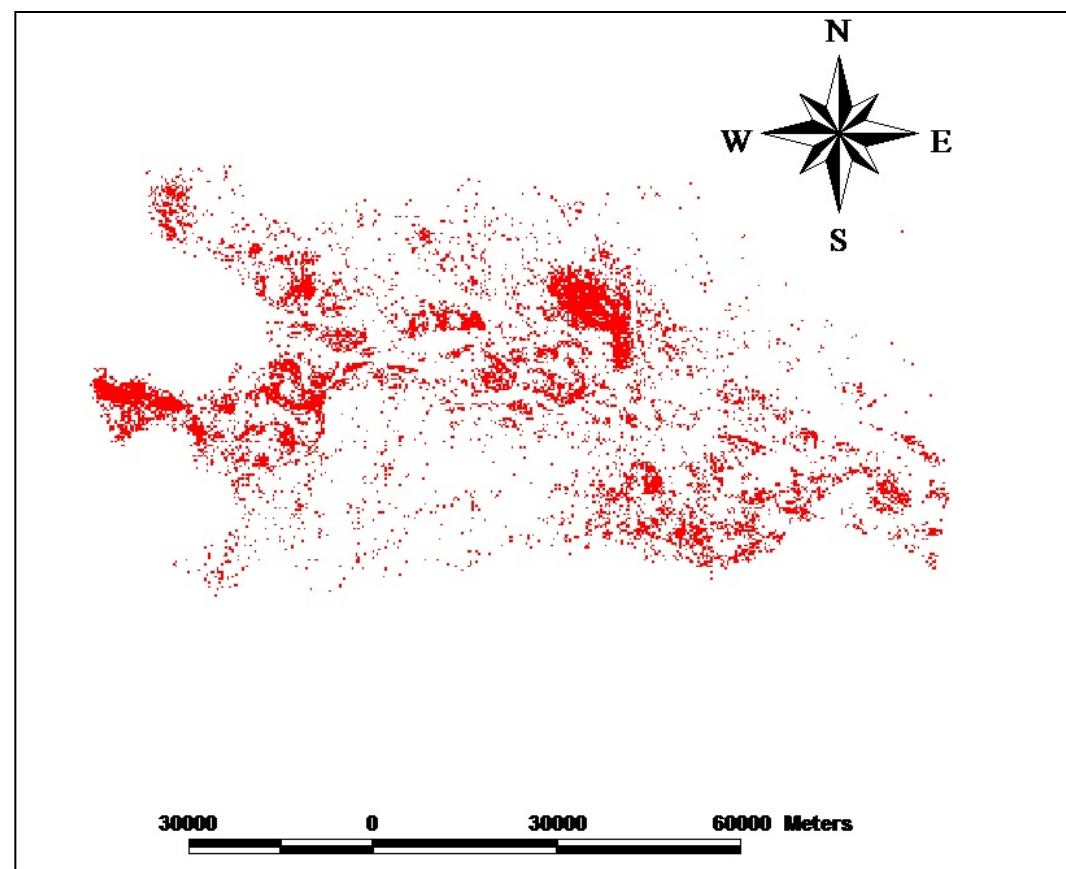
Figure 7. Flood occurrence map in flood susceptible zones (under very high and high classes).